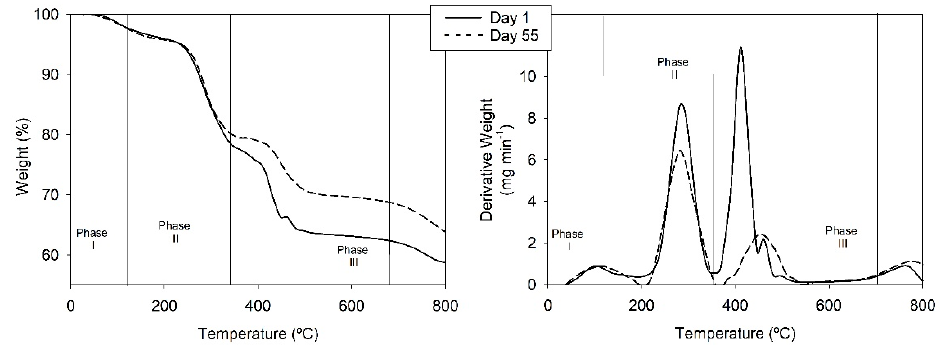
Figure 1. TGA [weight and DTG (derivative weight)] corresponding to the Municipal Solid Waste (MSW) evolution in composting (figures shown are from the authors).